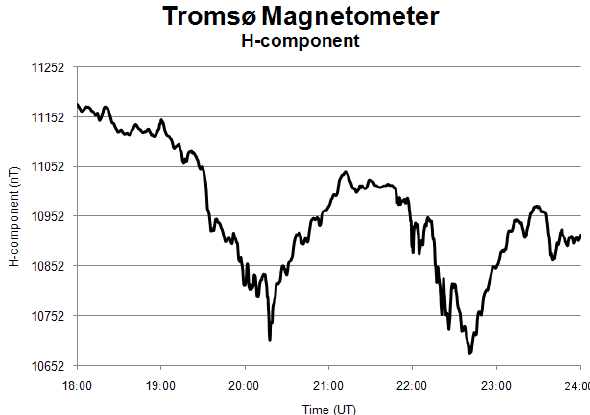
Fig. 1. The horizontal component of the magnetic field observed at Tromsø between 18:00UT and 24:00UT on 12 December 2001. The mean value of this component on 12 December 2001, the quiet field, was